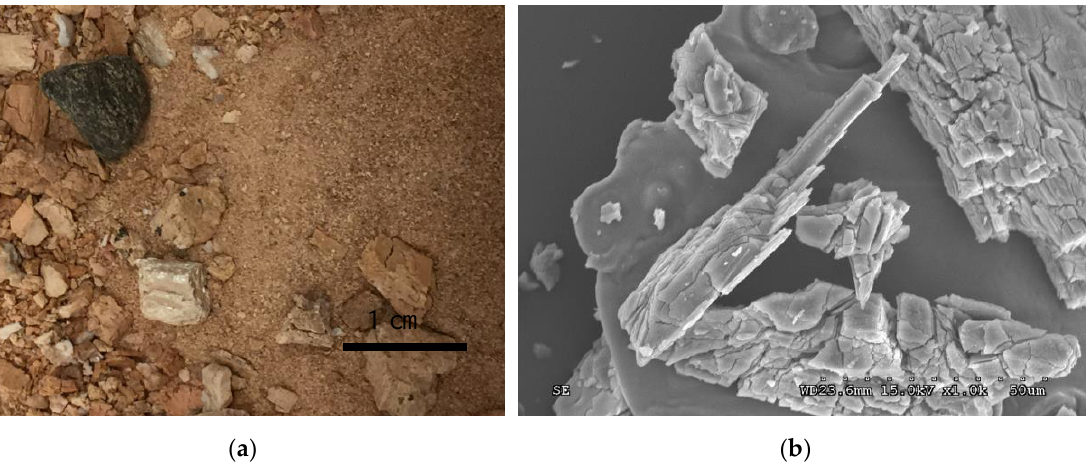
Figure 7. ( a ) Macroscopic (Optical), ( b ) Microscopic (SEM) aspects of a typical β-spodumene sample (red-brown particles) .